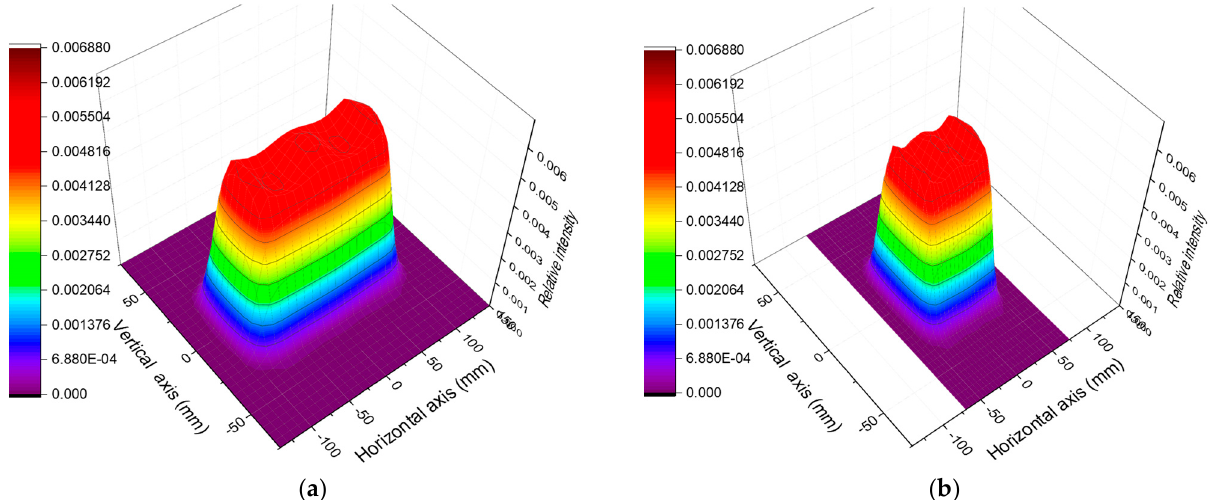
Figure 3. Deuteron beam footprints with normalized intensity. ( a ) “20 × 5” footprint; ( b ) “10 × 5” footprint.